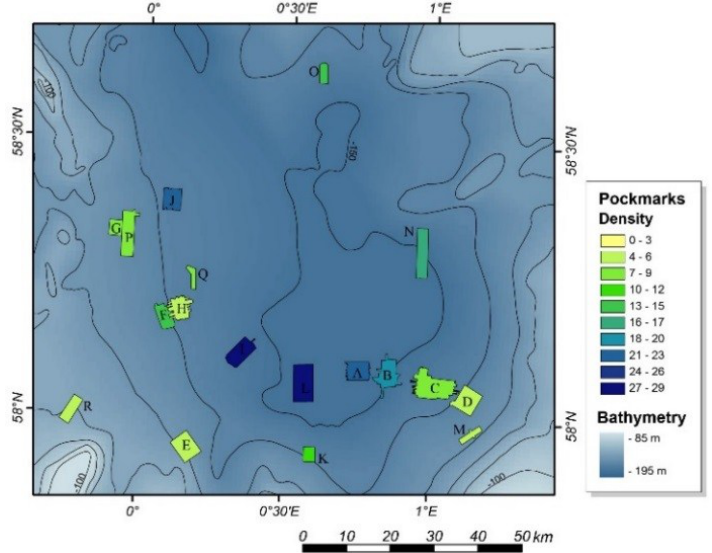
Figure 9. Pockmark density across the Witch Ground Basin. Survey sites colour coded according to the pockmark density observed. The regional bathymetry shows deeper areas (−150 m) in a darker blue and shallower areas (−90 m) in light blue [9].